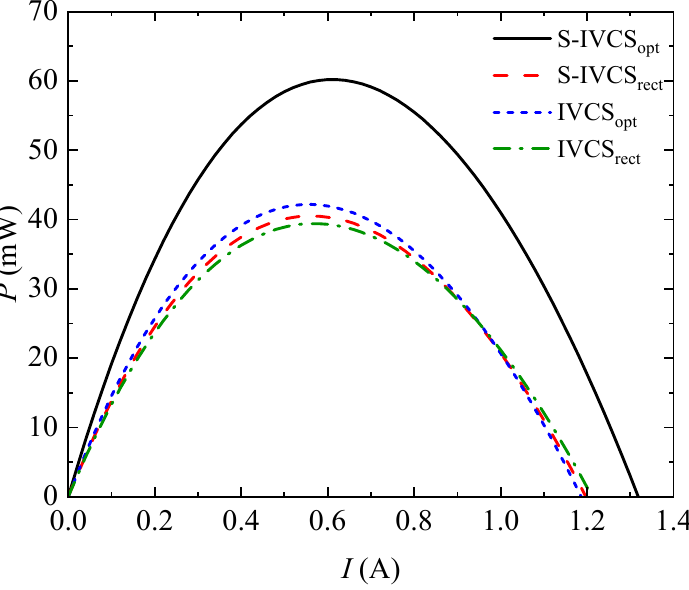
Figure 10. Comparison of the I - P curves for the four designs.